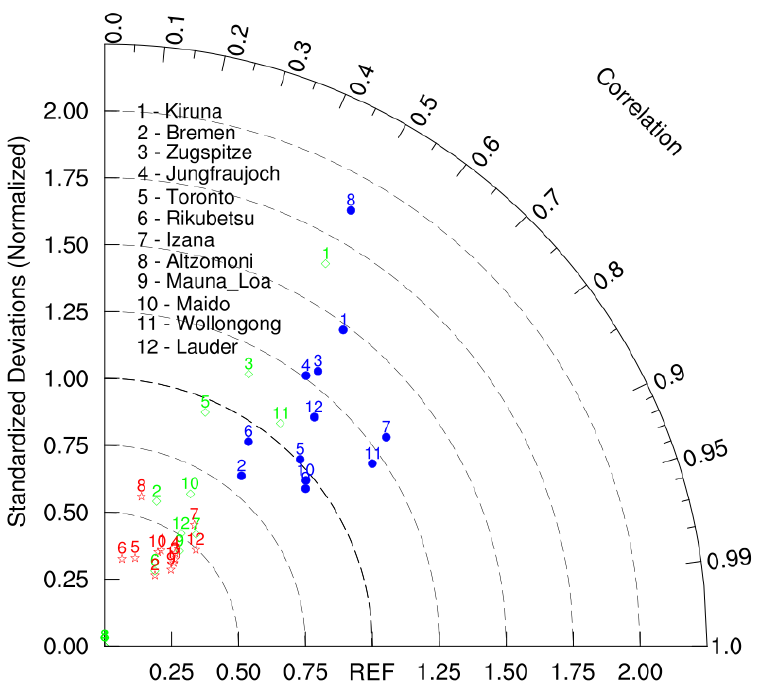
Figure 5. Taylor diagrams for the SOFRID versus FTIR monthly N 2 O VMRs comparison for the LT (green diamonds), MT (blue circles) and UT (red stars) at the 12 NDACC stations (Table